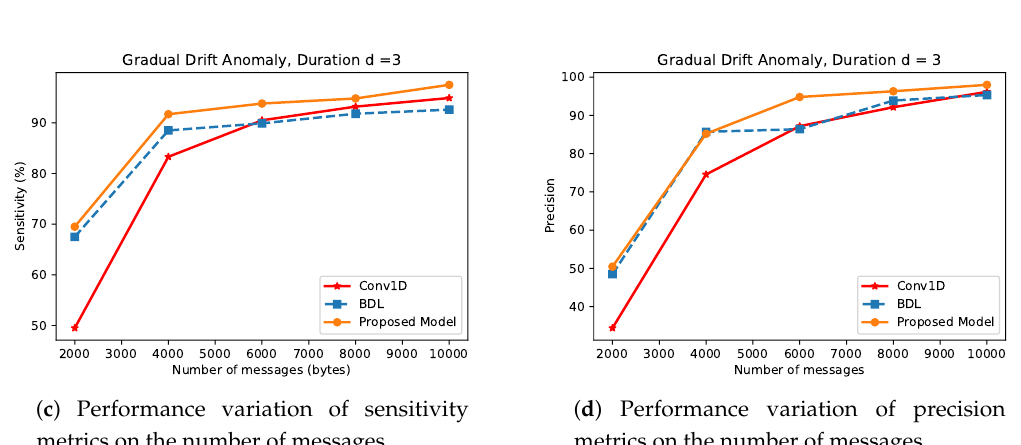
Figure 11. Detection Performance of Gradual Drift Anomaly type for CNN, BDL and the Proposed